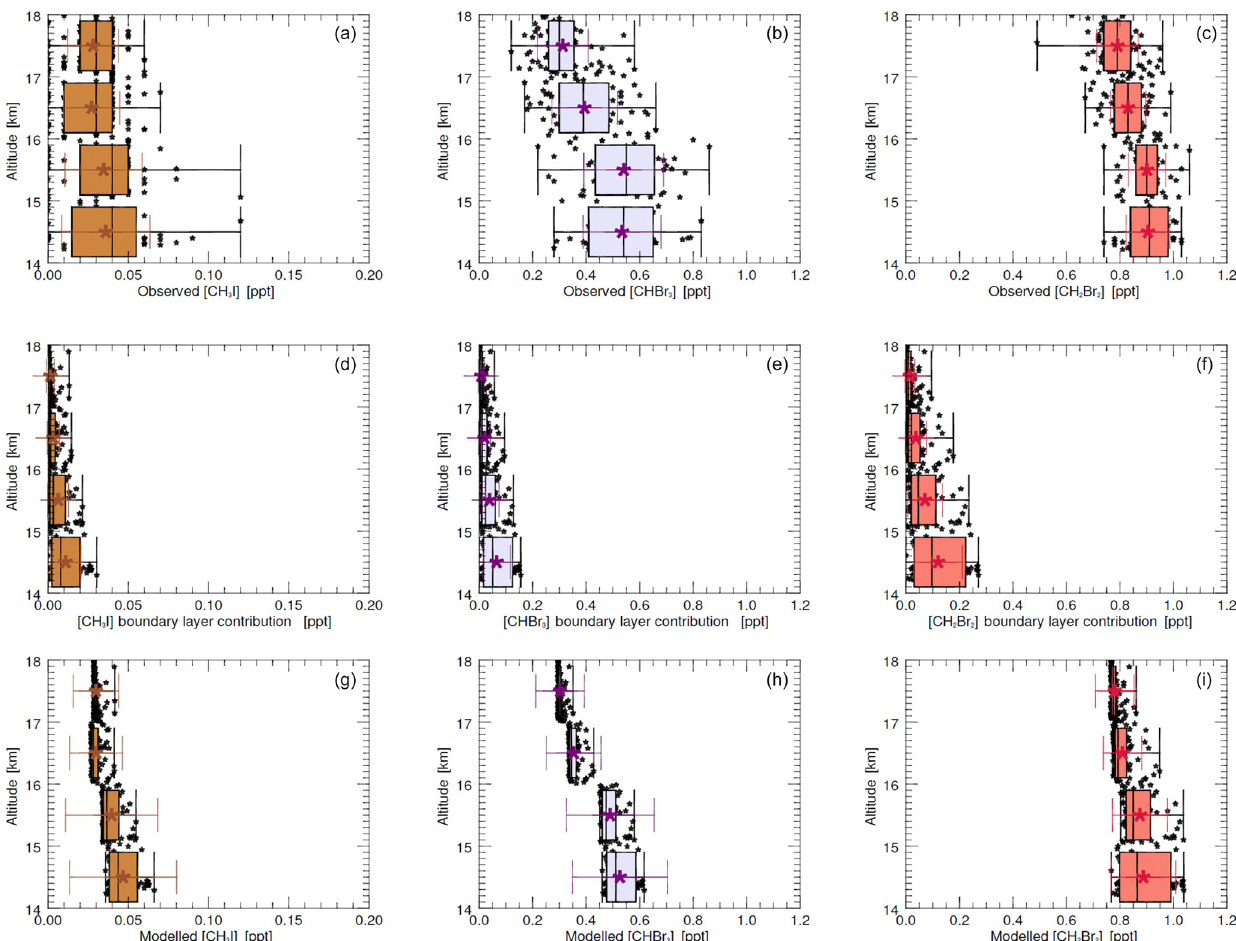
Figure 8. CH 3 I, CHBr 3 and CH 2 Br 2 vertical distribution in the TTL for ATTREX 2013 flights: AWAS observations (a–c) , NAME-modelled boundary layer contribution (d–f) , and NAME-modelled sums of boundary layer and background contributions (g–i)